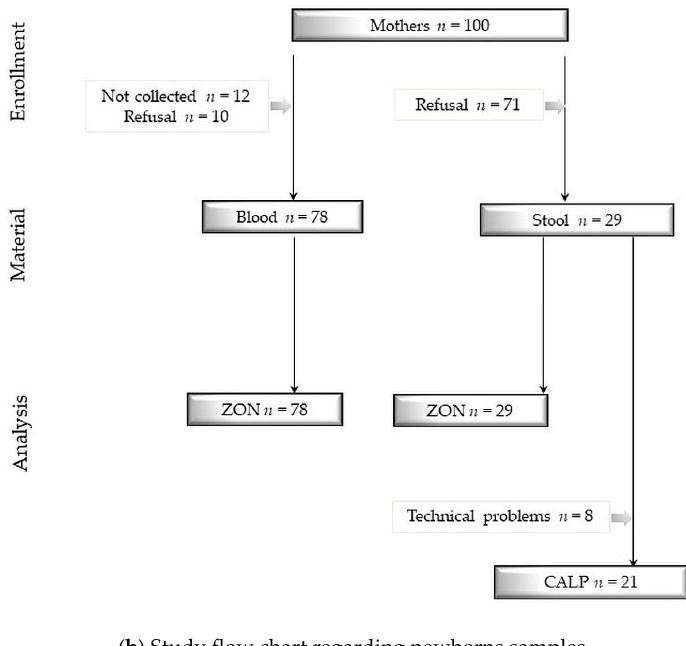
Figure 2. ( a ) Study flow chart regarding newborns samples. ( b ) Study flow chart regarding newborns samples. Study flow charts. Legend: ZON: zonulin, CALP: calprotectin, LOD: limit of detection, numbers and reasons for abandoned samples are listed in frames. Technical problems were sometimes caused due to a small volume of collected stool specimen. Determination limit for zonulin concentration = 800 ng/mL and for calprotectin concentration = 2100 µ g/mL. Table 2. Zonulin concentrations (ZON) (ng/mL) in the blood and stool of mothers and newborns, with correlations. Stool ZON Median